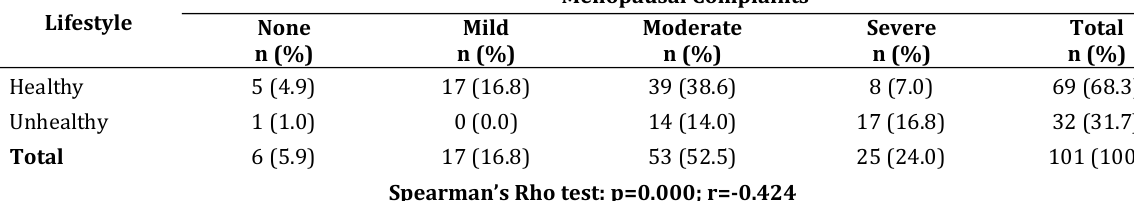
Table 3. Lifestyle to Menopausal Complaints (n=101) Lifestyle